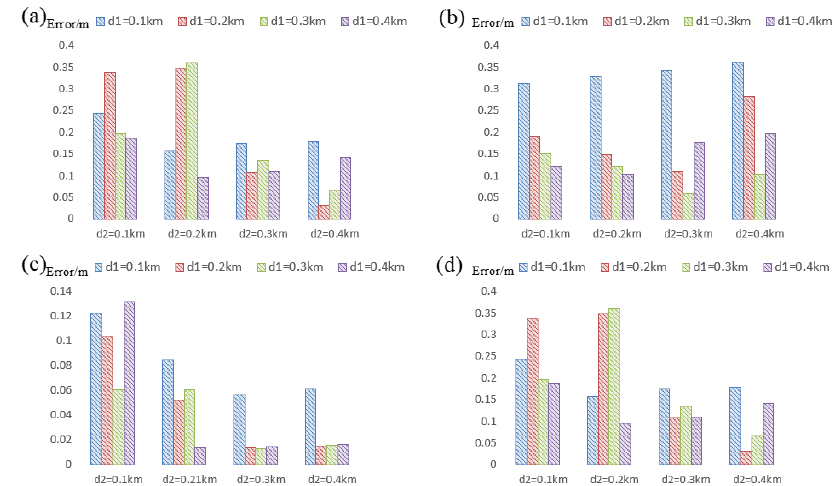
Figure 2. Relationship between the position errors and the spacing of the receiving subsystems. ( a ) The error in the direction of the x -axis. ( b ) Error in the direction of the y -axis. ( c ) Error in the direction of the z -axis. ( d ) Magnitude of the errors.